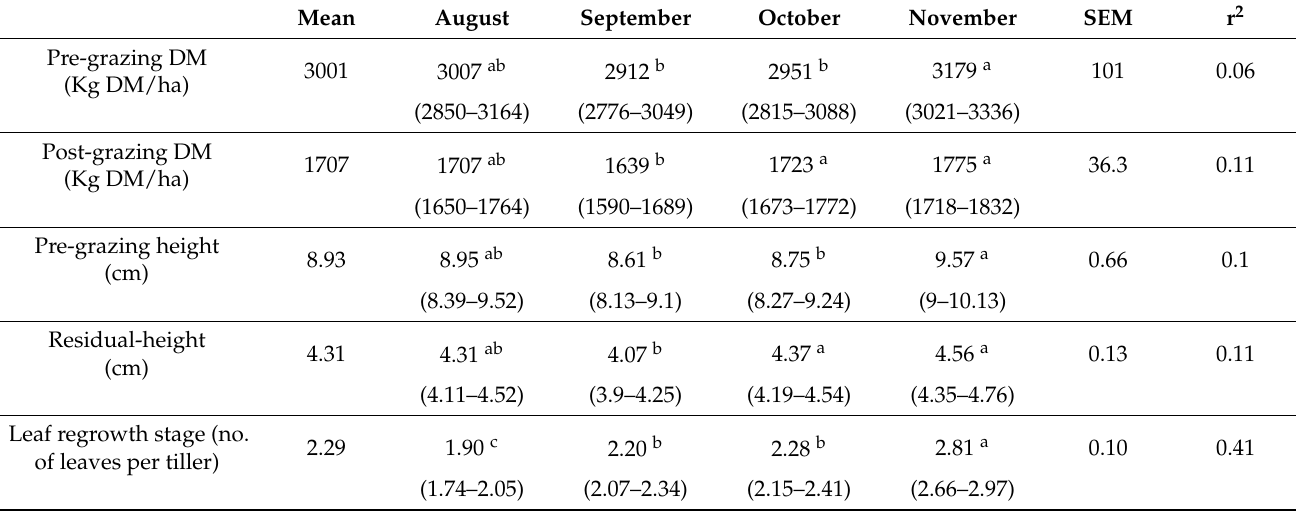
Table 5. The pre- and post-grazing pasture measurements (mean ± 95% confidence interval) ( n = 112).